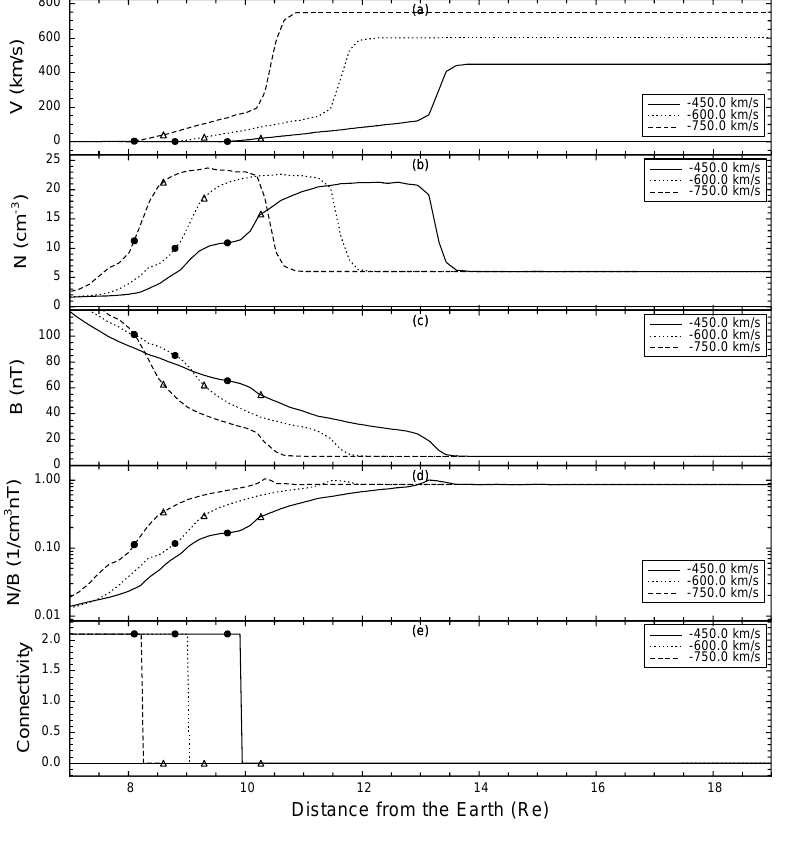
magnetic field boundary and they also move closer to the GSE z=0